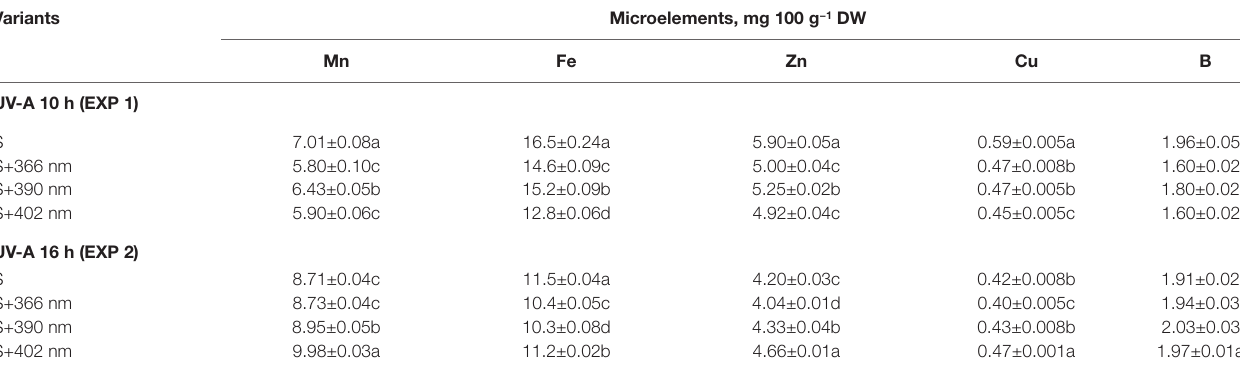
TABLE 3 | The effect of supplemental UV-A LED radiation on the microelements of microgreens.